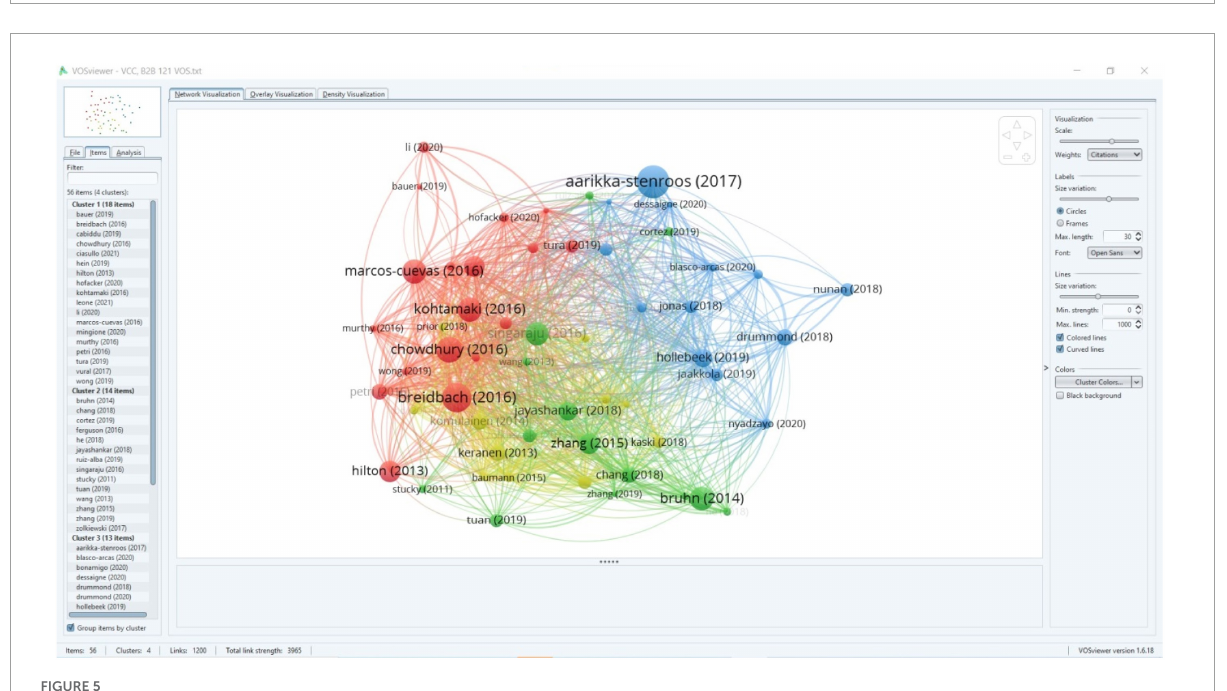
FIGURE5 Bibliographic couplings using VOS